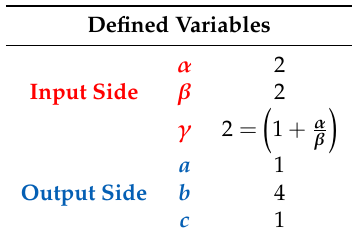
Table 6. Values for the six parameters for a four-module Input-Series Input-Parallel Output-Series (ISIPOS) power